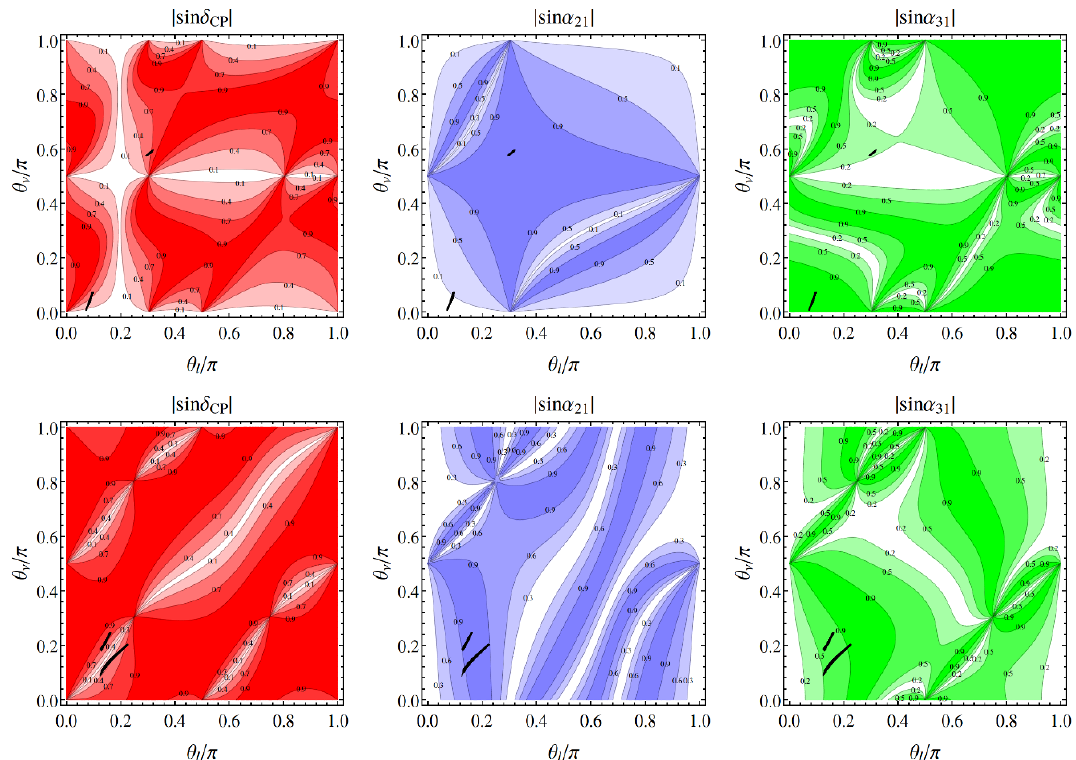
Figure 6 . The contour plots of the CP violation phases j sin (cid:14) CP j , j sin (cid:11) 21 j and j sin (cid:11) 31 j for the mixing pattern U II ; 1 , where the parameters ( ’ 3 ; ’ 4 ) are equal to (0 ; (cid:25)= 4) in the upper panels and ( (cid:25)= 4 ; (cid:25)= 2) in the lower panels. The black areas represent the regions for which all the three lepton mixing angles lie in their corresponding experimentally allowed 3 (cid:27) intervals [8]. Since U II ; 1 and U II ; 3 are related through the exchange of the second and the third rows of the mixing matrix, they lead to the same Majorana phases (cid:11) 21 and (cid:11) 31 while the Dirac phase changes from (cid:14) CP to (cid:25) + (cid:14) CP